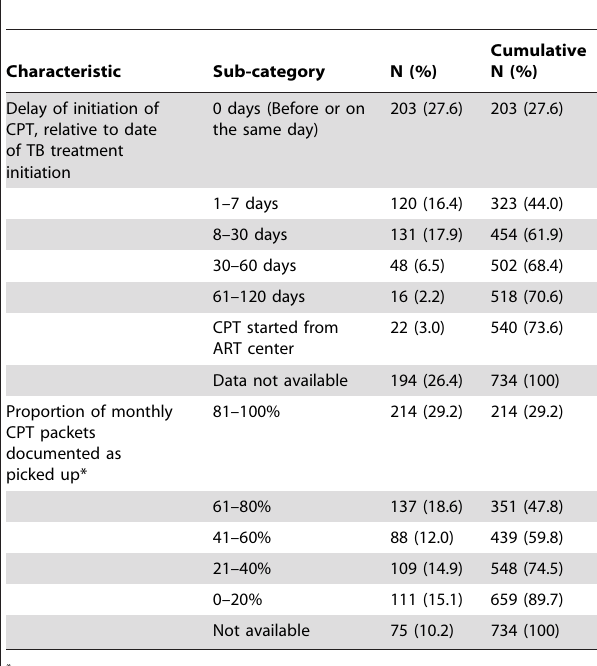
Table 2. CPT initiation delay and adherence among HIV- infected TB patients, Andhra Pradesh 2007 (N =734).